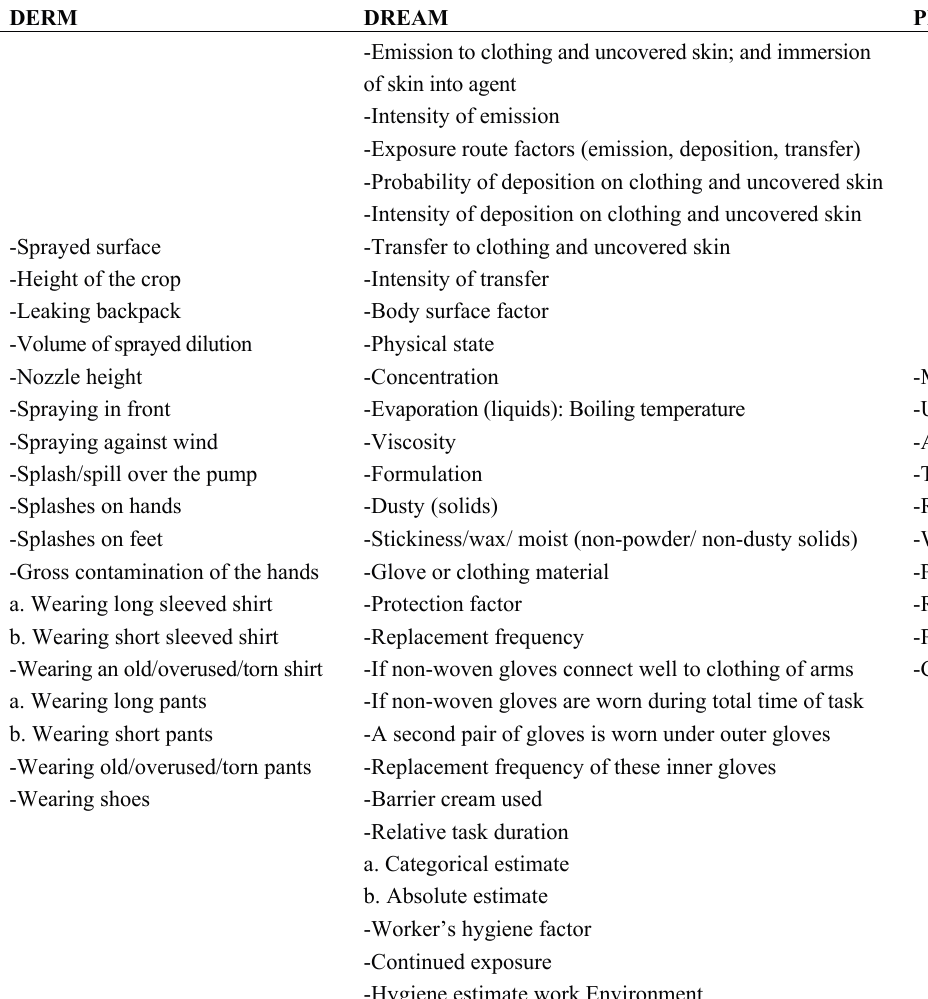
Table 4. Determinants considered by the Evaluated